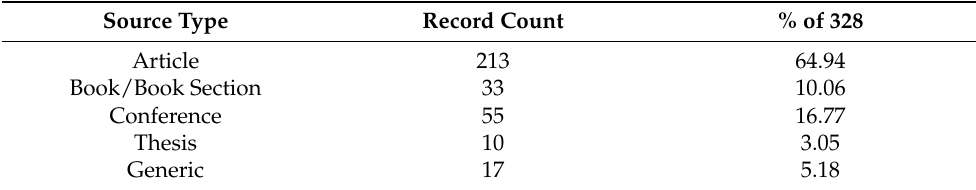
Table 1. Types of Table 1. Types of sources.